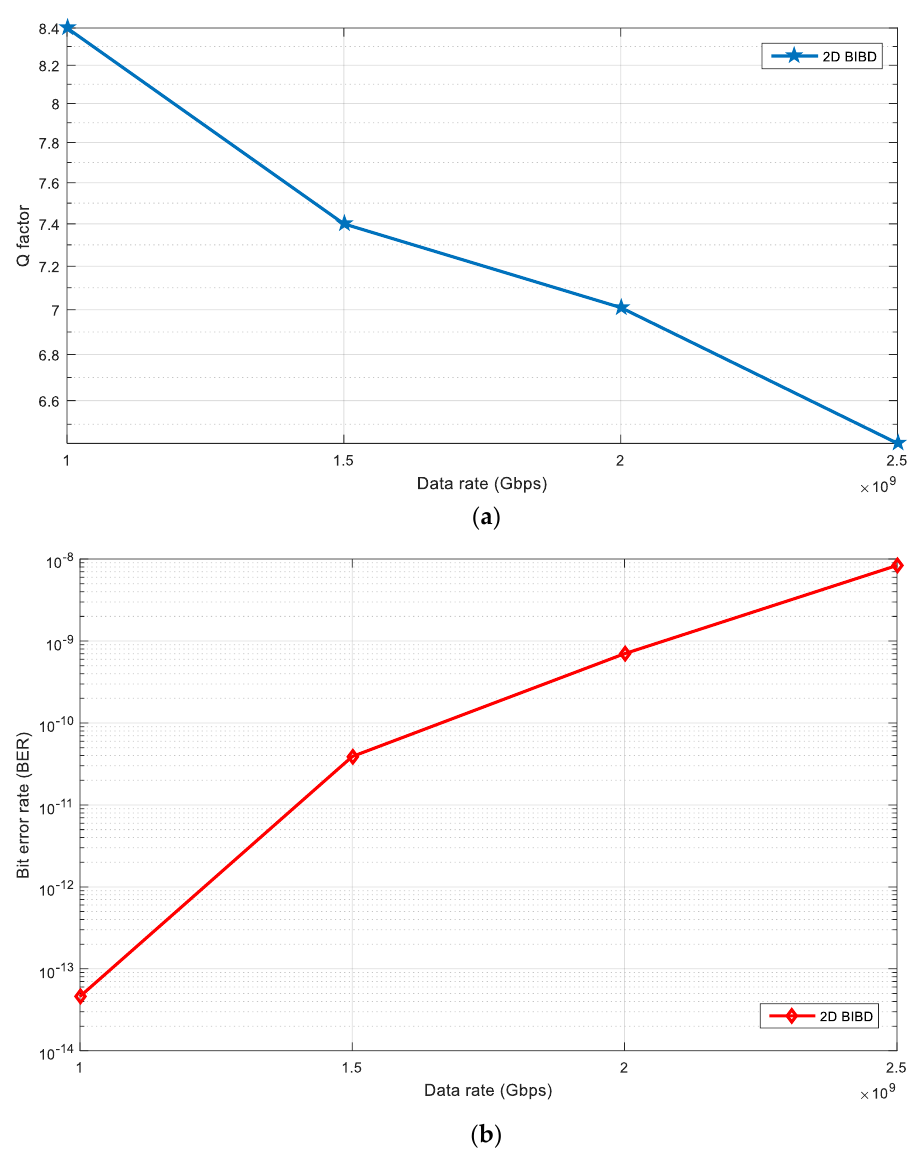
Figure 9. Data rate versus: ( a ) Q factor, ( b ) BER for six users at − 10 dBm received power.